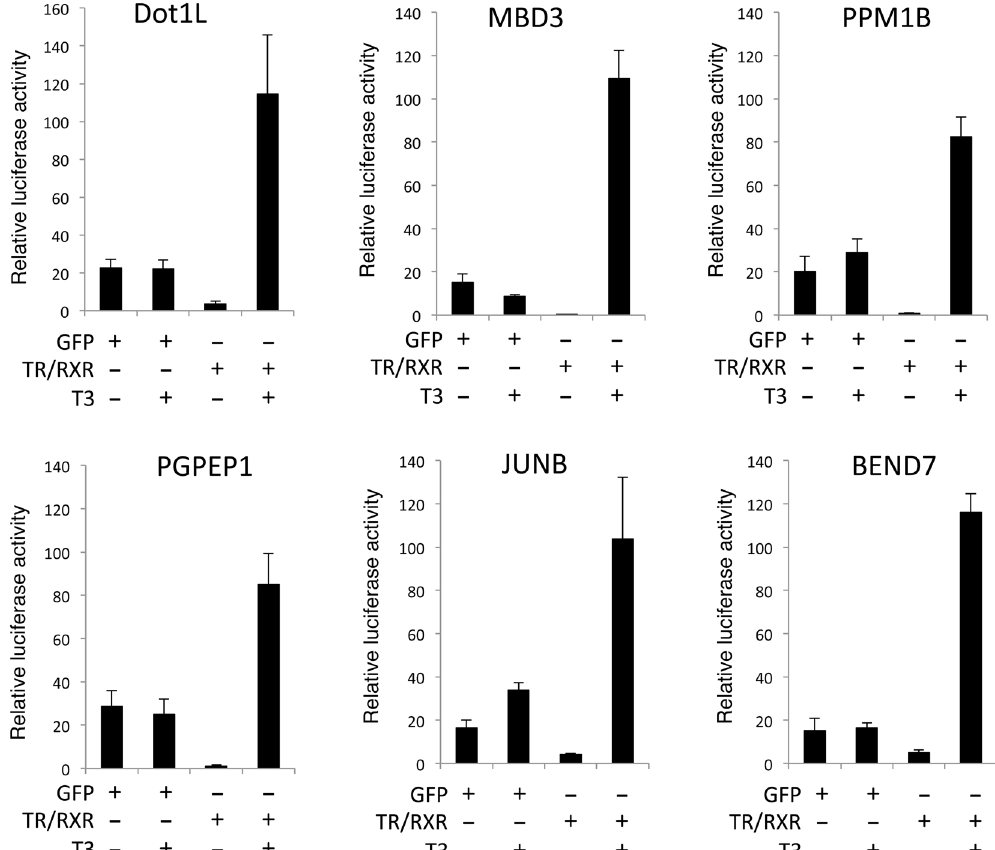
Figure 5. The putative TREs in the candidate TR target genes can mediate transcriptional activation by T3 in frog oocytes. The luciferase reporter construct containing the TREs of Dot1L, MBD3, PPM1B, PGPEP1, JUNB, BEND7, respectively, was co-injected with the control Renilla luciferase construct phRG-TK into the nuclei of Xenopus oocytes with or without prior cytoplasmic injection of Xenopus laevis TR α and RXR α mRNAs or GFP mRNA as negative control. The oocytes were incubated at 18 °C overnight in the presence or absence of 100 nM T3 and then used for dual luciferase assays. The relative activities of the firefly luciferase to Renilla luciferase were plotted. Note that all the reporters responded to T3 in the presence of